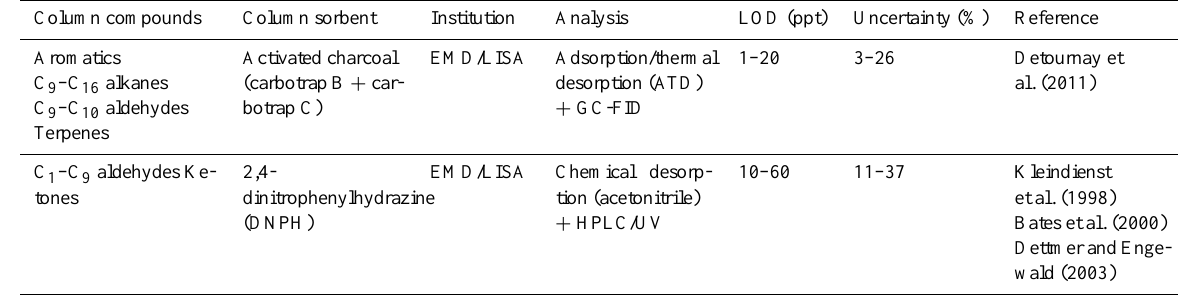
Table 1. Offline measurements of the gaseous organic carbon during MEGAPOLI at SIRTA. Column compounds